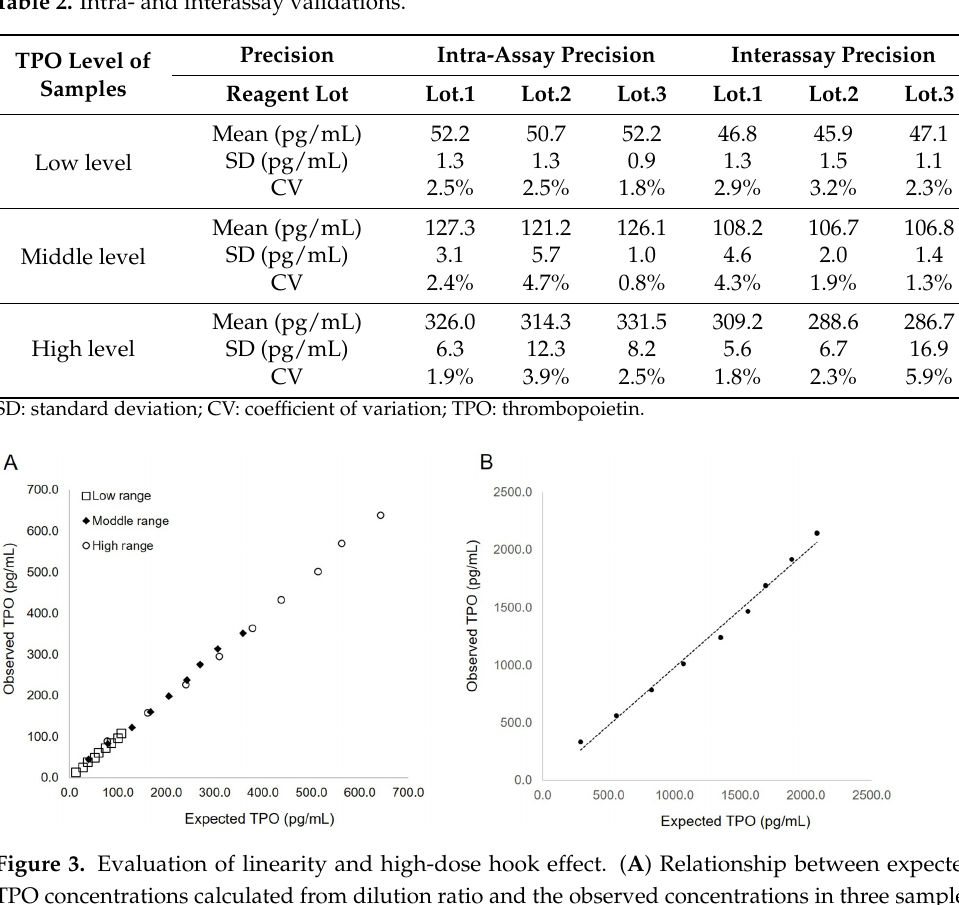
Figure 3. Evaluation of linearity and high-dose hook effect. ( A ) Relationship between expected TPO concentrations calculated from dilution ratio and the observed concentrations in three samples. ( B ) Relationship between expected TPO concentrations and observed high TPO concentrations beyond the dynamic range. TPO, thrombopoietin. From the LoQ results, the functional sensitivity at 15% CV was 3.4 pg/mL (Figure 4A); based on these results, the dynamic range for this reagent was defined as 3.4–700 pg/mL. From the LoD results, the analytical sensitivity was 1.3 pg/mL (Figure 4B).